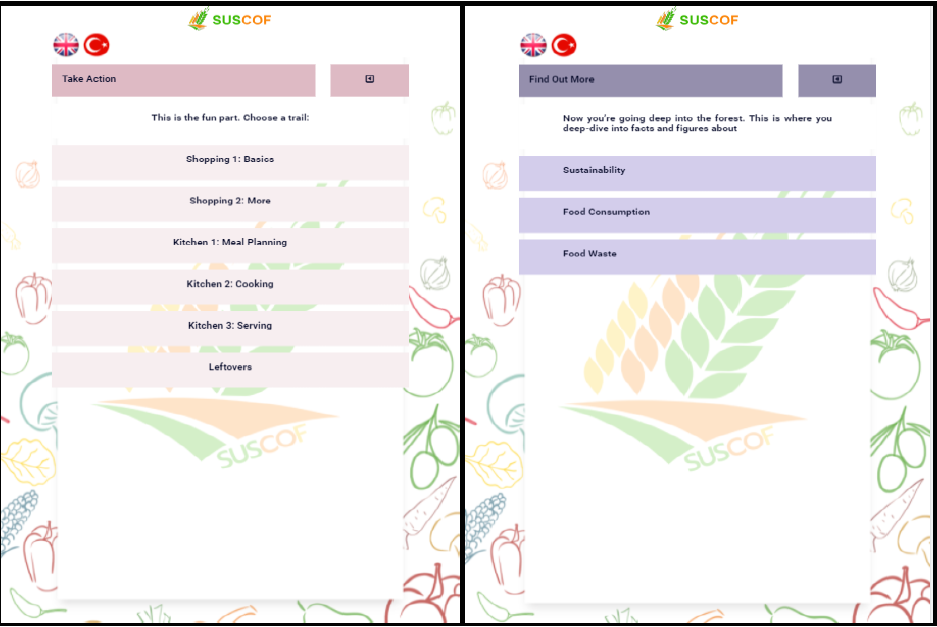
Figure 7. “Investigate More Content” Screen and Contents. Coding HTML 5 language was used for the front ‐ end coding of the application. JavaScript language was used to support this language. The Boostrap front ‐ end library was used to run the application on different platforms (https://getbootstrap.com/ accessed on 30 May 2022). Net language was used in the back ‐ end programming of the application. The Net language is an OOP ‐ object ‐ oriented programming language developed by Microsoft from the C language. The application is coded using the Visual Studio 9 platform. Coding tests were conducted with various browsers and emulators. The application was developed in Net language, on the Visual Studio 2018 IDE. MsSQL 2018 was used as database. jQuery language is used for client side processes. A